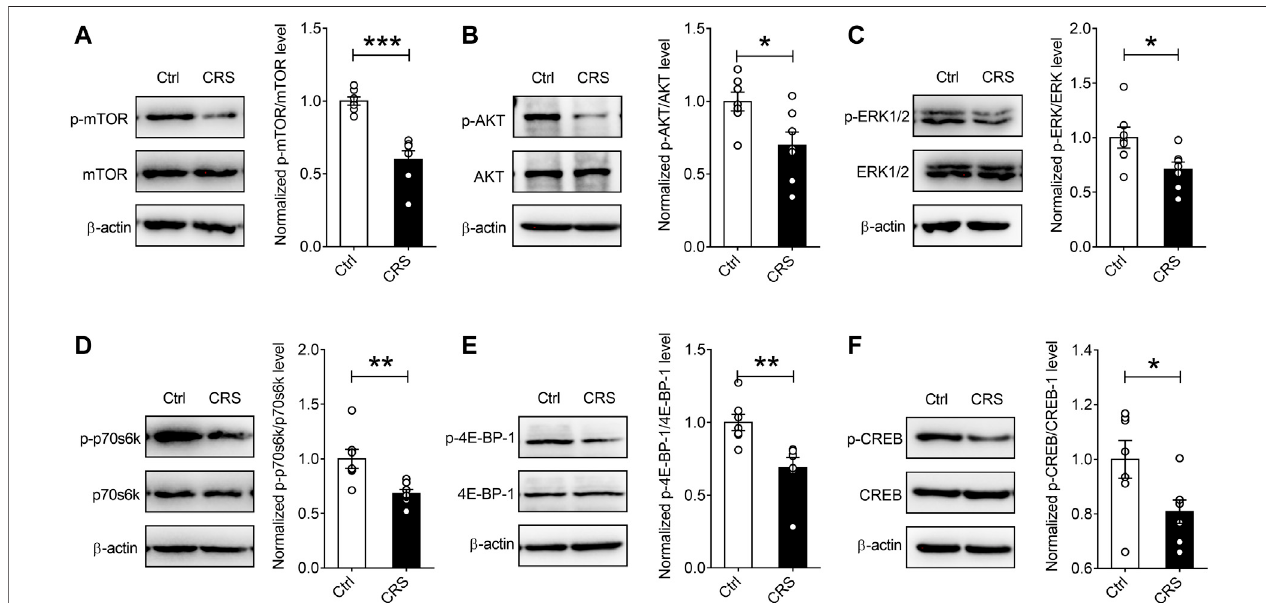
FIGURE 4 | CRS mediates protein synthesis decreases by targeting mTORC1 signaling in the hippocampus. CRS signi fi cantly decreased the phosphorylation levelsofthemTORC1signalingpathway-associatedtargets,suchasp-mTOR (A) ,p-Akt (B) ,p-ERK (C) ,p-p70S6K (D) ,p-4E-BP-1 (E) andp-CREB (F) ;whilenoeffects on the expression of total mTOR, Akt, ERK, p70S6K, 4E-BP-1 and CREB were observed. Data are presented as mean ± SEM. One-way ANOVA for all. n (cid:1) 7 per group for all. * p < 0.05, ** p < 0.01, *** p < 0.001 vs. Ctrl group.